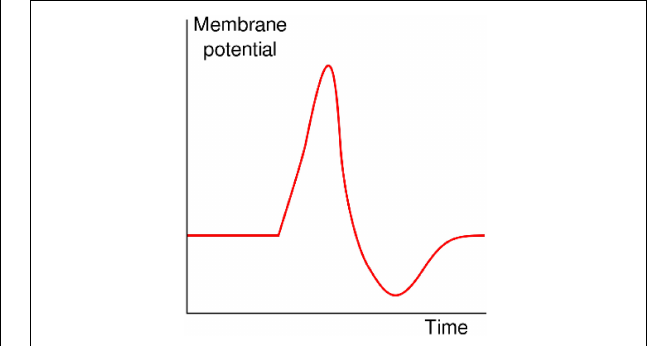
FIGURE 4 | Shape of a typical action potential. The membrane potential remains near a baseline level until at some point in time, it abruptly spikes upward and then rapidly falls